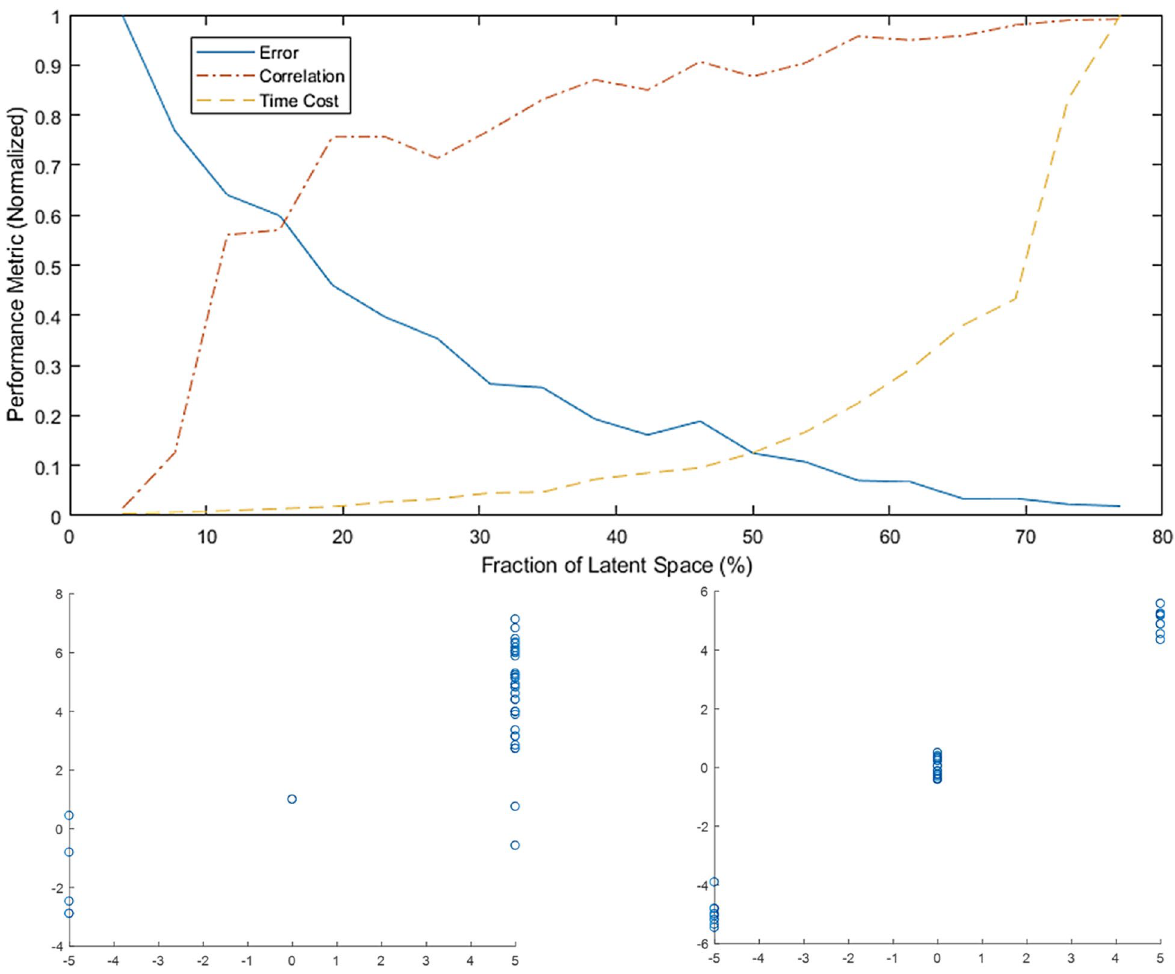
Figure 2. Reconstruction performance (training) of the proposed ensemble (size 5) decomposition approach at the critical feasibility set size and critical missing information size (50%). Top: fitness, error and computational cost versus the laten space size. The validation results demonstrate the stability of the CIC framework and validate the optimization efficiency of the presented tensor decomposition approach. Both error and computational cost are normalized with respect to their respective highest values in the simulations. Bottom: comparison between the reconstruction performance without SOMs (left) and with SOM (right) of a categorical feature with three classes. A five-unit difference is used to allow appropriate separability between the classes. In the simulations without SOMs, the middle class (value of zero) observations are stacked on top of each other, showing only one visible value. This is due to the influence of its size (the majority of the observations are in the middle class, prompting unfavorable reconstruction